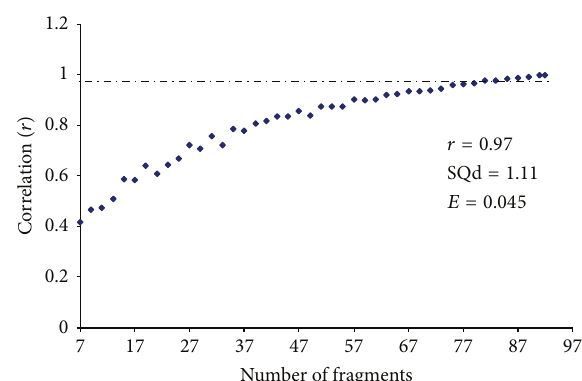
Figure 1: Resampling analysis (bootstrap) and the correlation ( 𝑟 ) with number of fragments from the Rio Grande population. SQd is the squared sum of the deviations in relation to the new samples; 𝐸 is the stress value.